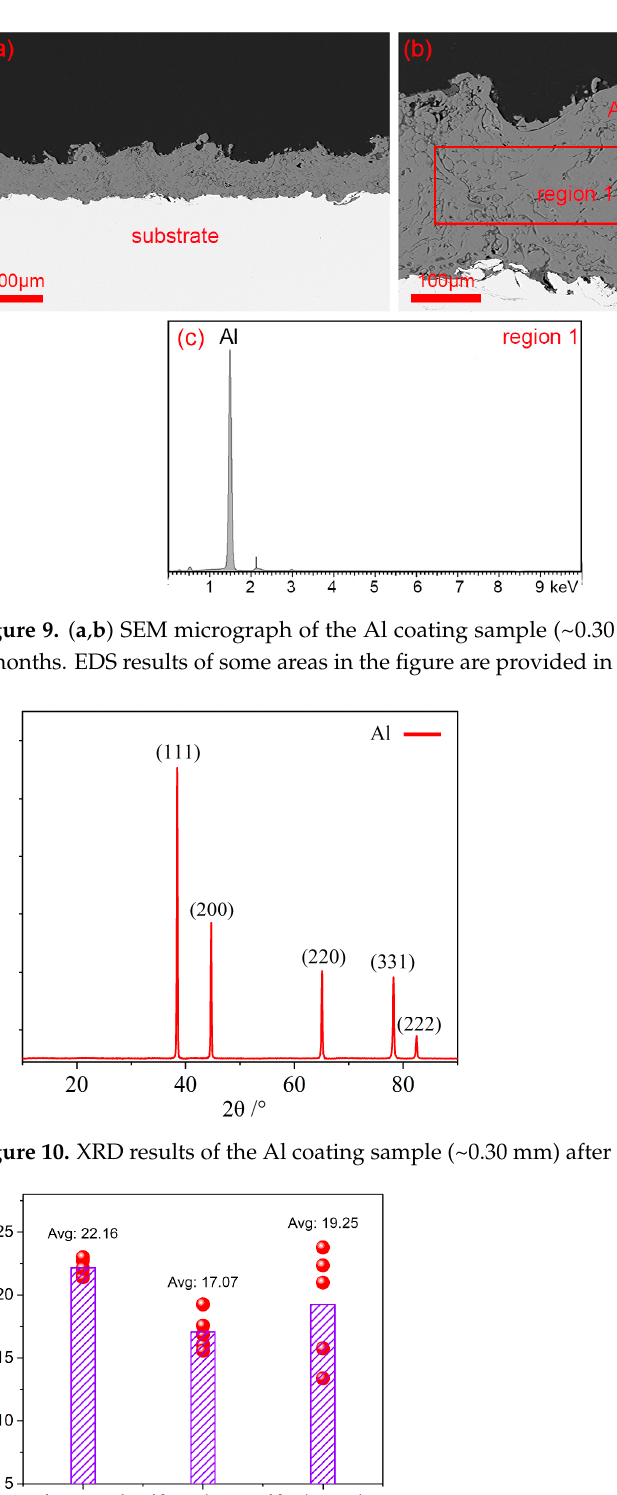
Figure 11. Adhesion of thermal spray coatings before and after